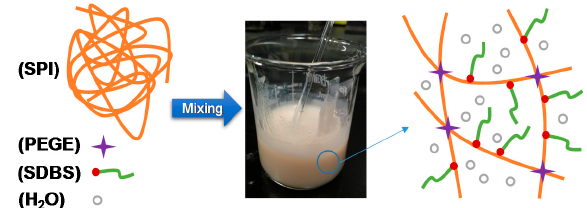
Figure 1. Cross-linking reaction mechanism of SPI and PEGE with the presentence of SDBS.